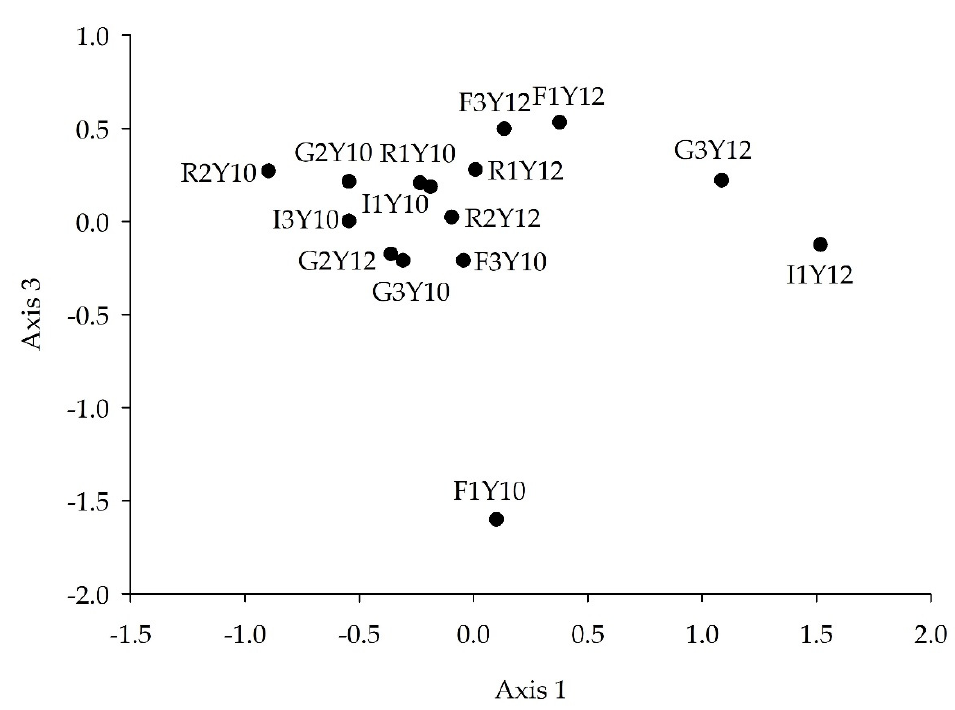
Figure 7. Axis 1 versus 3 (45% variance explained) reach sampling event distributions for the non- metric multidimensional scaling analysis of macroinvertebrate assemblages at 8 land use/land cover sites in 2010 and 7 sites in 2012 (F = Forest, G = Golf, I = Industrial, R = Residential; Y10 = 2010, Y12 =2012).